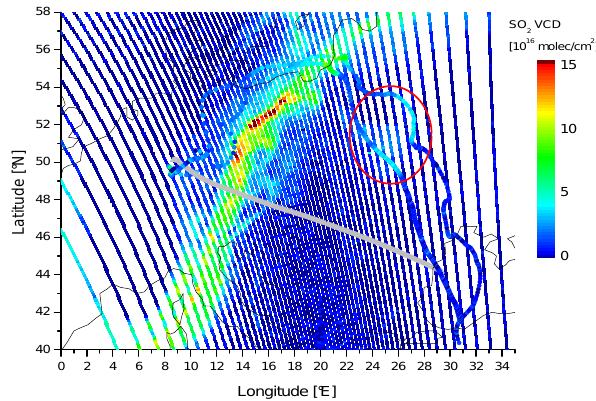
Fig. 13. Comparison of the CARIBIC data to the OMI satellite observation (http://disc.sci.gsfc.nasa.gov/Aura/data-holdings/OMI/ omso2 v003.shtml,march2010). In grey the flight track is shown and the CARIBIC and OMI VCDs are colour coded. Obviously the position of the small sub plume does not match for either the TRAJKS model (south) nor for the optimized wind speed (north). The main plume also does not match for neither of the